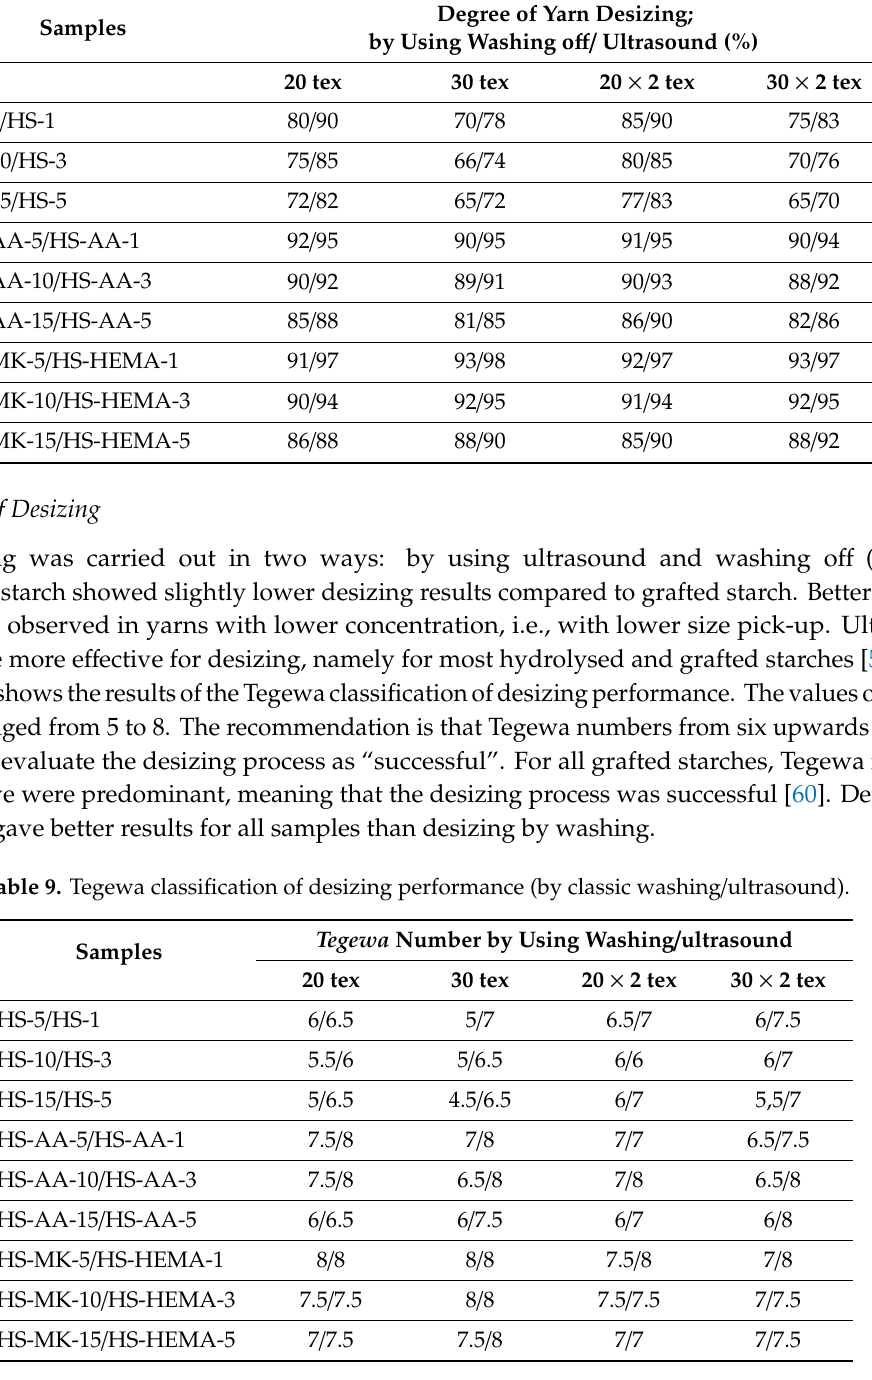
Table 8. Degree of yarn desizing by using washing / ultrasound. Samples